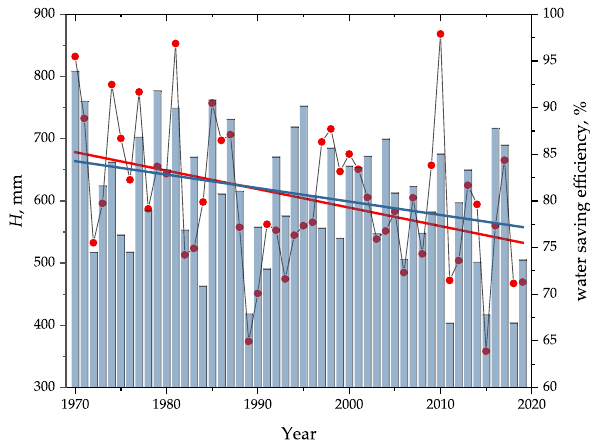
Fig. 8 Trend line of water saving efficiency (red line) and annual pre- cipitation (blue line) in Opole between 1970 and 2019, annual effi- ciencies (red dots) and annual precipitation totals (blue